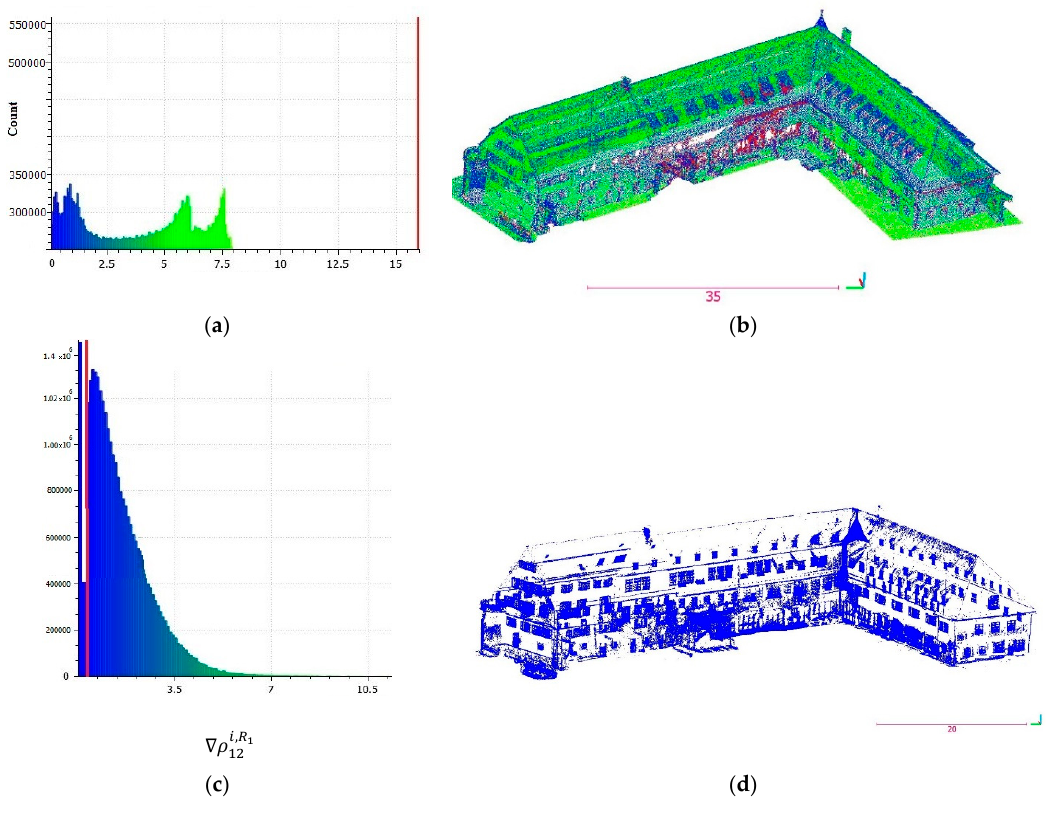
Figure 14. Filtering the point cloud. ( a ) Histogram of 𝜌 (cid:2869)(cid:2870) , ( b ) Points labelling according to the histogram of 𝜌 (cid:2869)(cid:2870) , ( c ) Thresholding the histogram of 𝛻𝜌 (cid:2869)(cid:2870)(cid:3036),(cid:3019) (cid:3117) and ( d ) The filtered the point cloud.